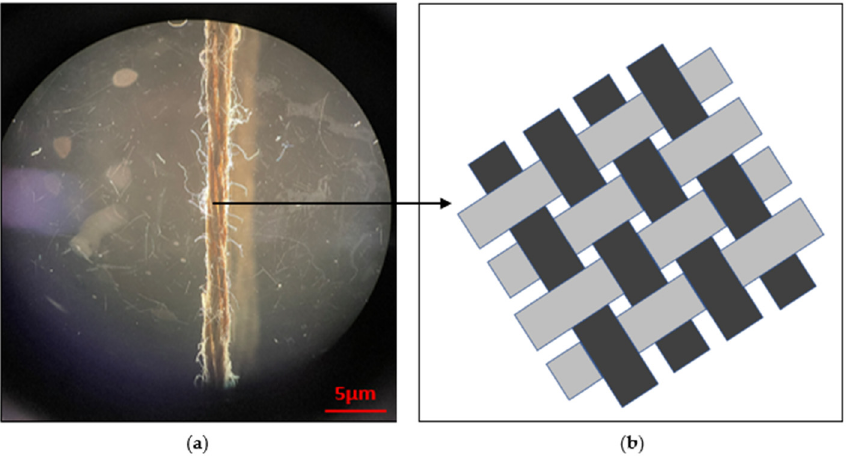
Figure 1. Arrangement of fiber spools on braiding machine.